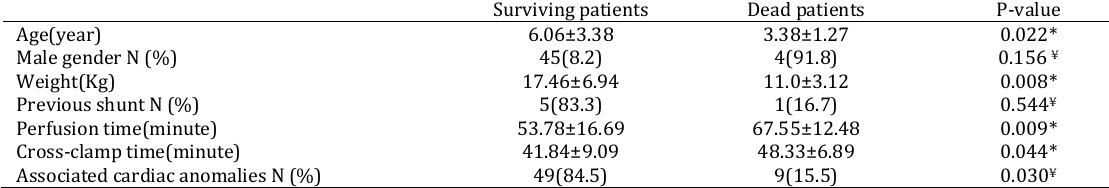
Table 4. Variables associated with postoperative mortality